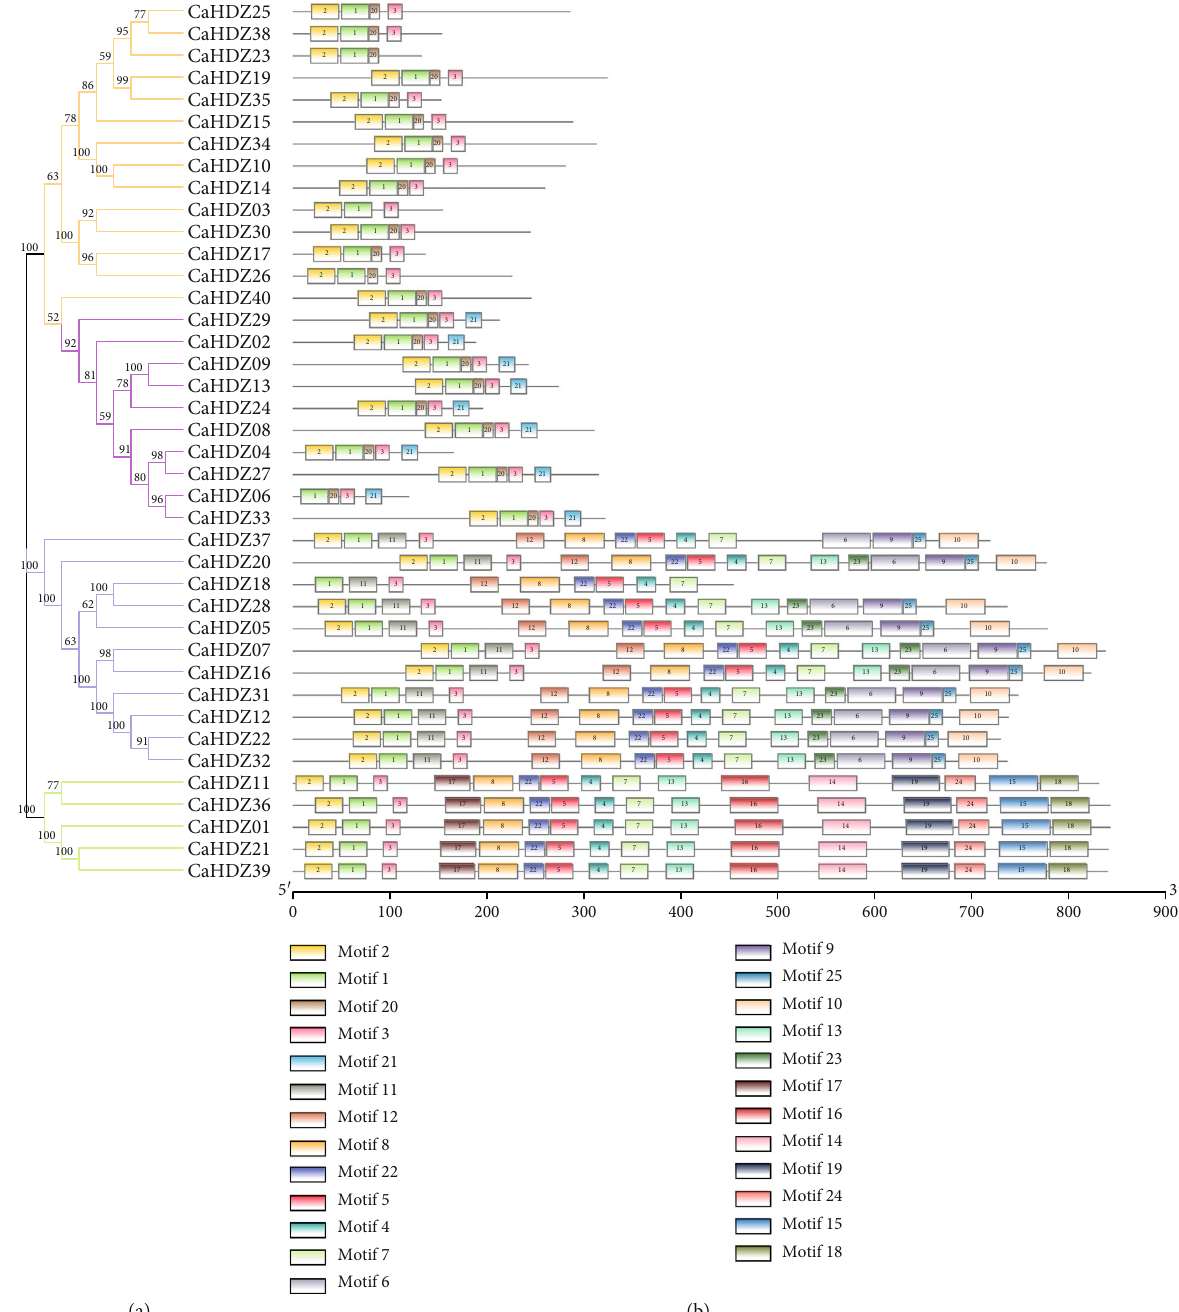
Figure 1: Unrooted neighbor-joining phylogenetic tree and conserved motif analysis of CaHD-ZIP proteins. (a) The phylogenetic tree was generated based on the protein sequences of CaHD-ZIP proteins. (b) Conserved motif analysis of CaHD-ZIP proteins. Di ff erent color boxes represent di ff erent types of